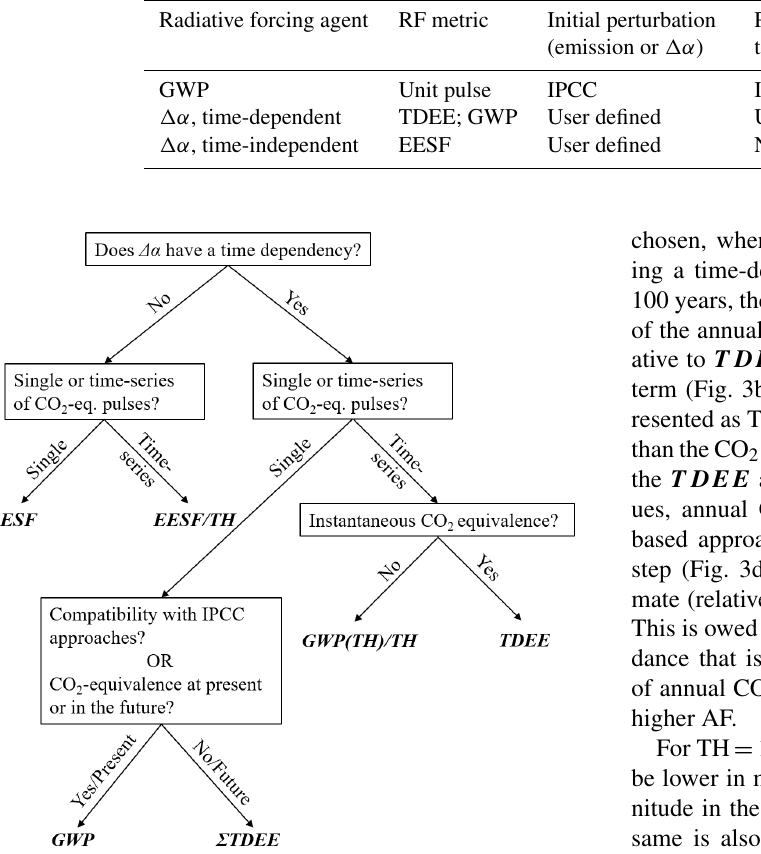
Figure 2. Decision tree for (cid:49)α metrics applied in the literature in- cluded in this